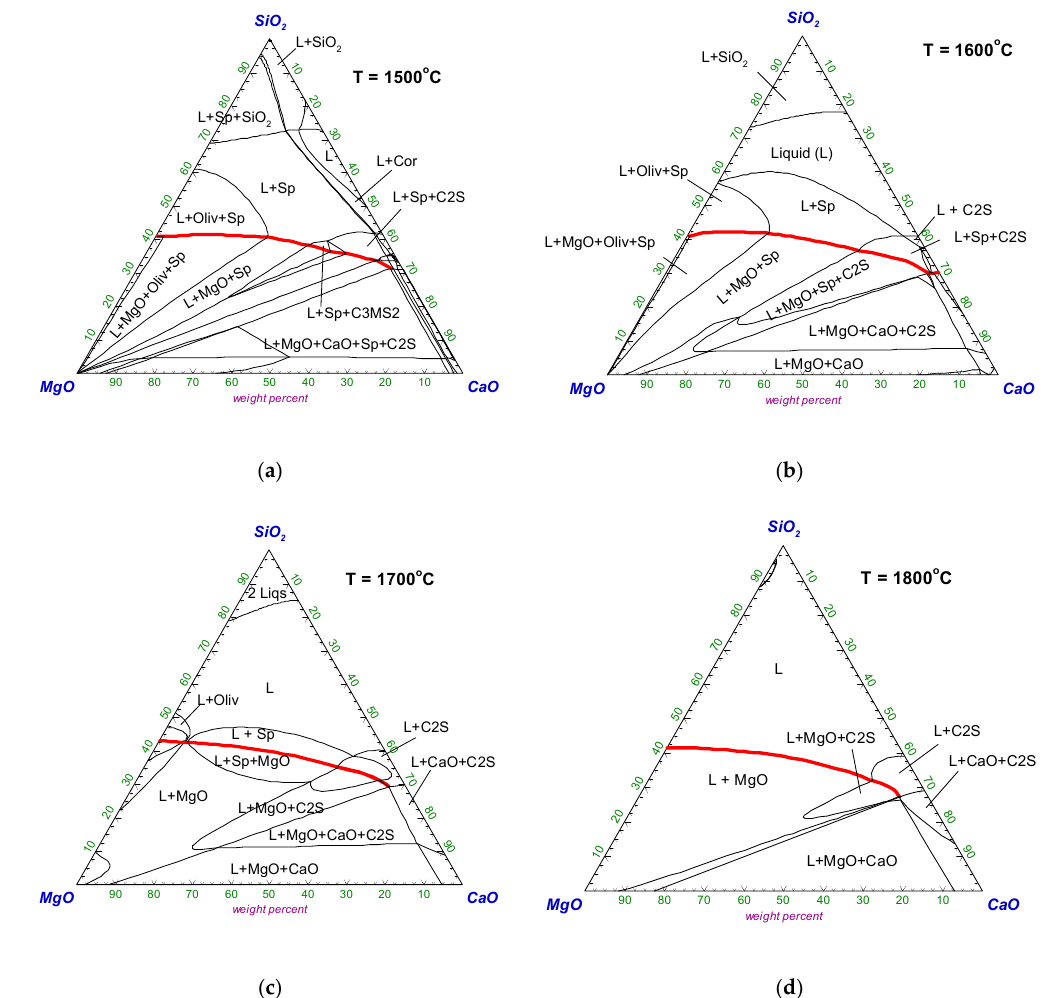
Figure 2. Calculated phase diagrams of the CaO-MgO-SiO2-5% Al 2 O 3 -5% Cr 2 O 3 at P(O 2 ) = 10 − 9 atm. ( a ) 1500, ( b ) 1600, ( c ) 1700 and ( d ) 1800 °C by FactSage (reproduced from [13], with permission from authors, 2016) Oliv = Mg 2 SiO 4 -rich olivine solution, Sp = Mg(Cr,Al) 2 O 4 spinel solution, C2S = Ca 2 SiO 4 solution, MgO = MgO-rich solution, CaO = CaO-rich solution, C3MS2 = Ca 3 MgSi 2 O 8 , Cor = (Cr,Al) 2 O 3 corundum solution. Thick red lines represent the MgO-rich solid saturation line. It should be noted that the axis of Gibbs triangle diagram is re-normalized in term of CaO + MgO + SiO 2 = 100 wt.%.